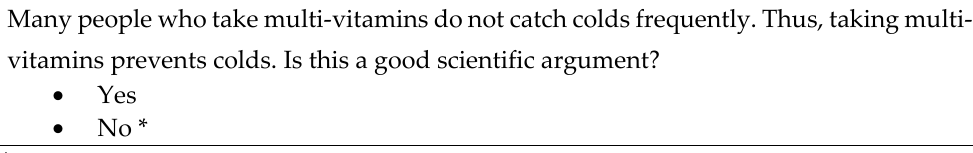
Figure 2. Sample science literacy question, non-equivalent samples.